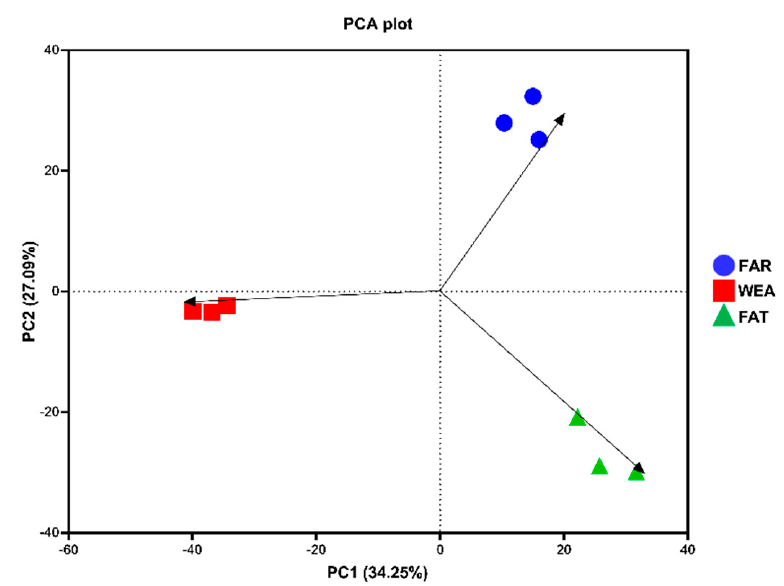
Figure 4. Principal component analysis (PCA) of samples from different types of pig houses. FAR, farrowing houses; WEA, weaning houses; FAT, fattening houses.